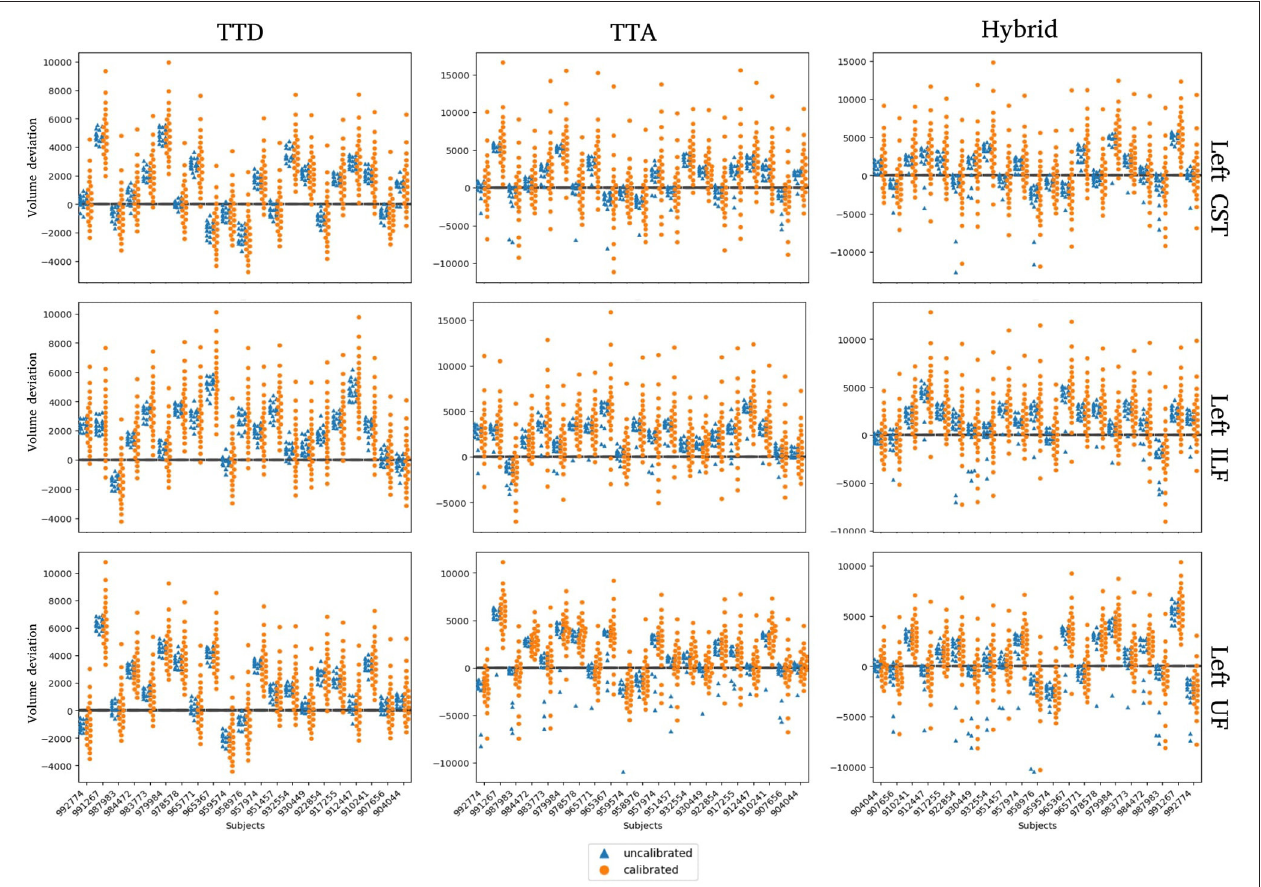
FIGURE 7 | Uncalibrated and calibrated predicted volumes for TTD, TTA, and Hybrid approaches. Volume deviation is computed as the predicted volume subtracted by the ground truth volume. For each subject, the ground truth (black horizontal line) is at zero, and the predicted volume deviation is more visually apparent.